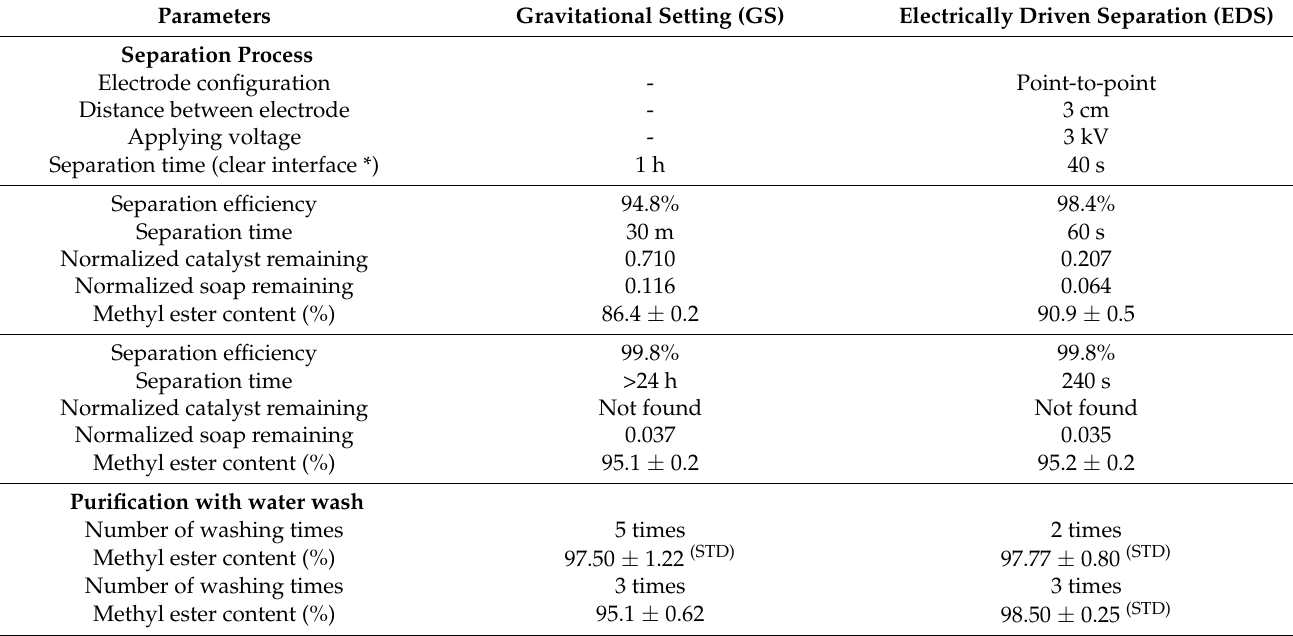
Table 3. Summary of the performance and optimum conditions of the separation process of biodiesel product mixture from crude glycerol by GS and EDS